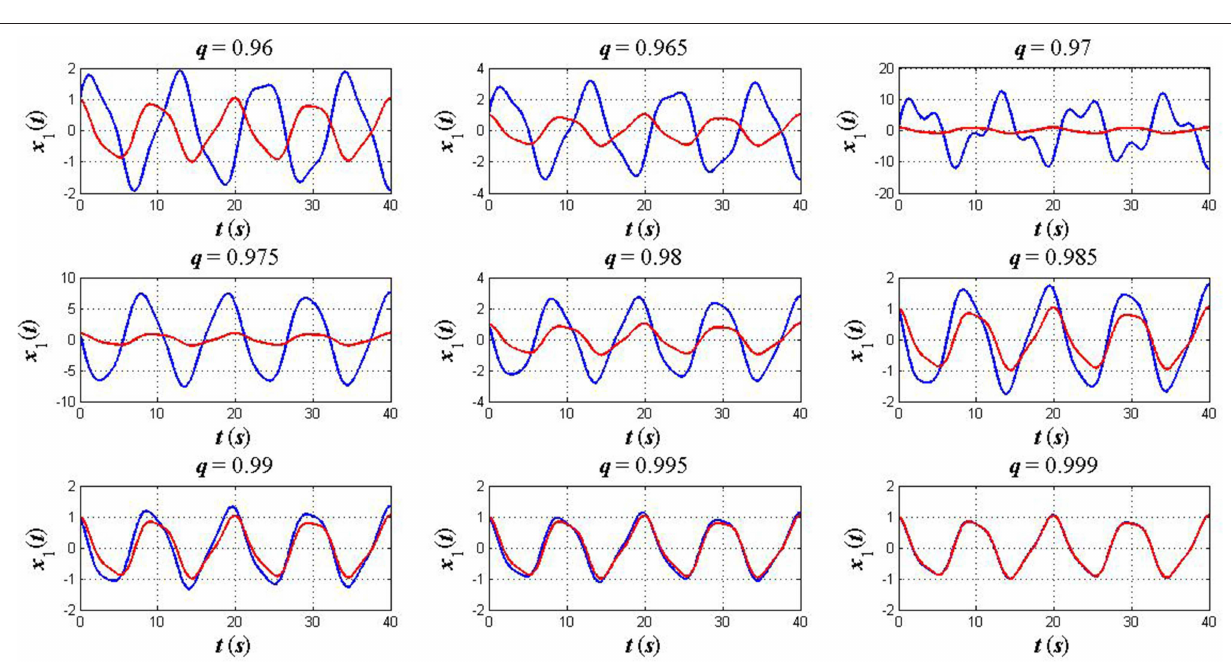
Frontiers in Physics |